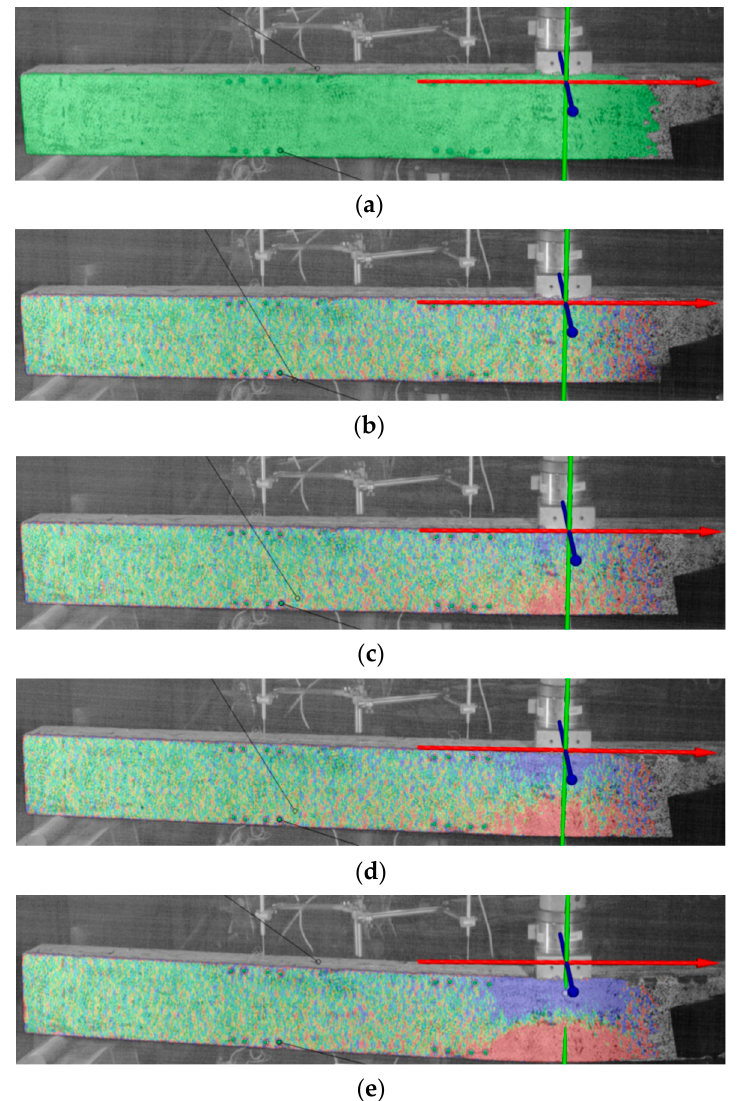
Figure 20. Strain maps in the direction parallel to the beam’s axis: ( a ) no load; ( b ) load: 105 kN; ( c ) load: 245 kN; ( d ) load: 285 kN; ( e ) load: 365 kN.